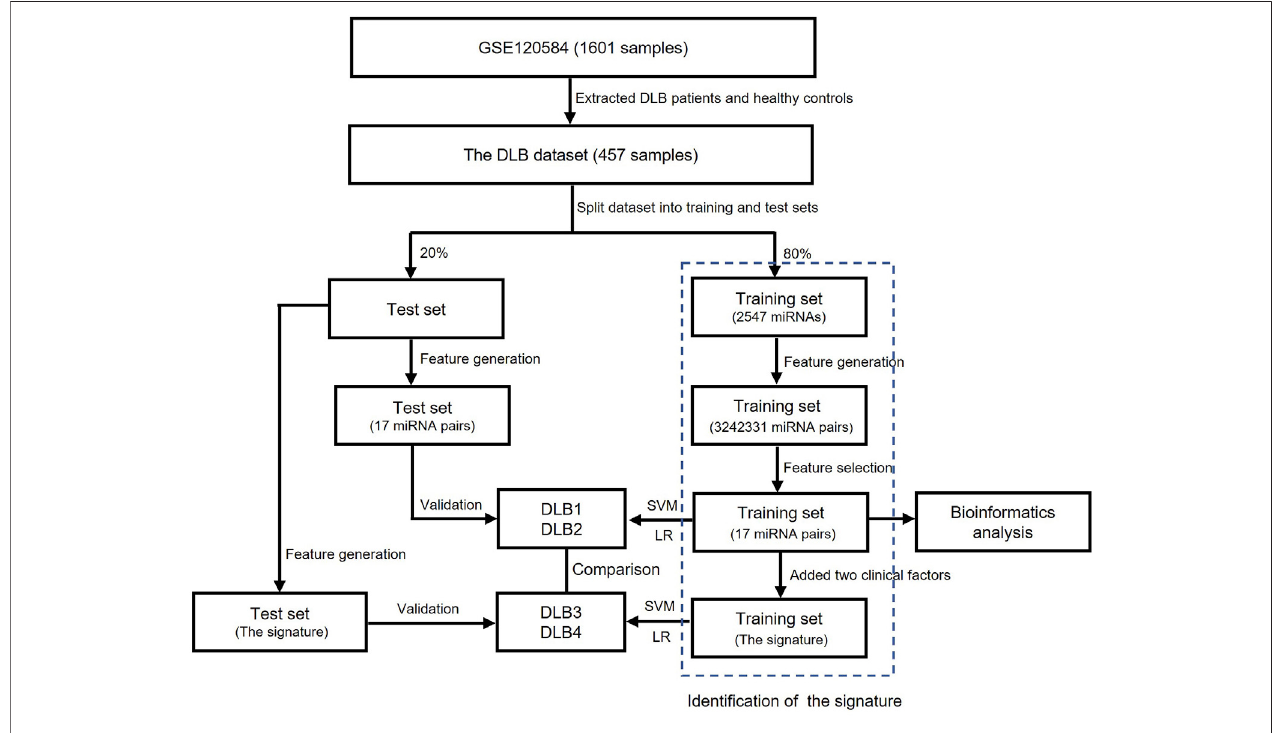
FIGURE 1 | The fl owchart of this study.